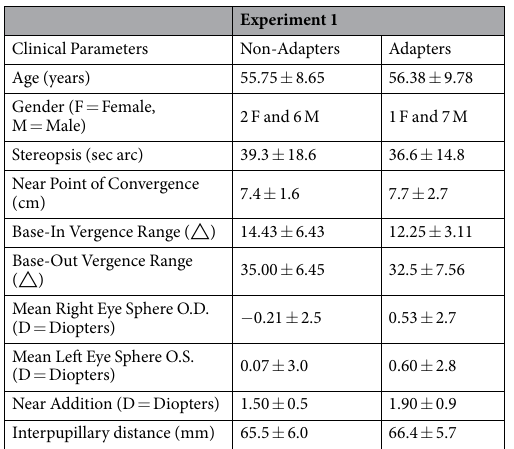
Table 1. Mean and Standard Deviation of Non-Adapters and Adapters to PALs Group Attributes for Experiment 1 Short-term Vergence Modification Experiment studying presbyopes with a history of wearing